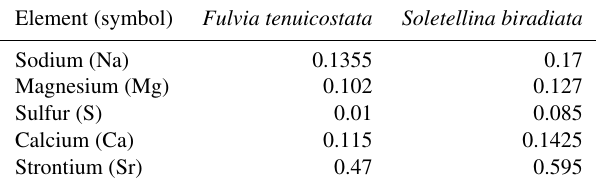
Table 3. The EPMA detection limits (3 σ) on bivalve samples. The Mg and Sr contents in both S. biradiata and F. tenuicostata were below the limits of detection (see Figs. 8 and